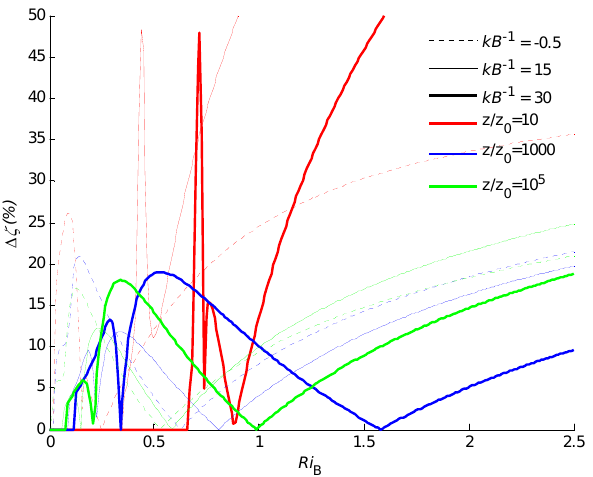
Fig. 8. Maximum (circles) and average (crosses) relative error of ζ for CB05 with five-step iteration (black lines), WRL12 (green lines) and the new scheme (red lines). Errors larger than 50% are not shown.